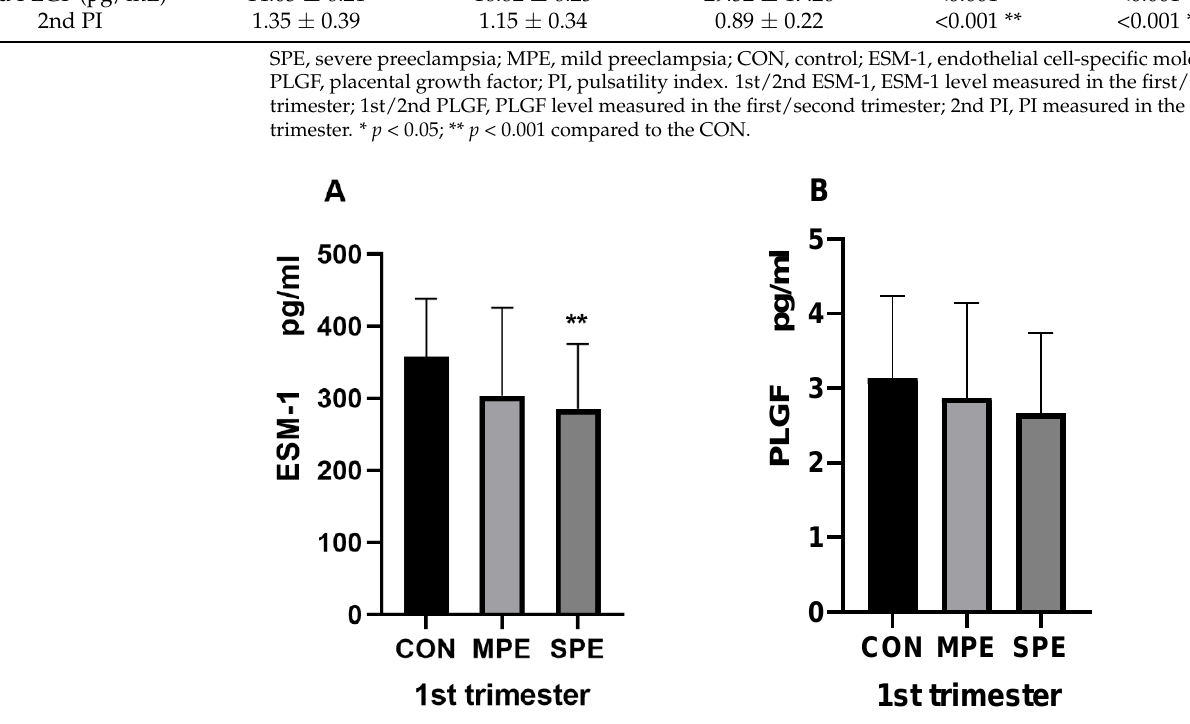
Figure 2. ESM-1 and PLGF in first-trimester maternal serum ( A , B ). CON, n = 60; MPE, n = 18; SPE, n = 33, ** p < 0.001.